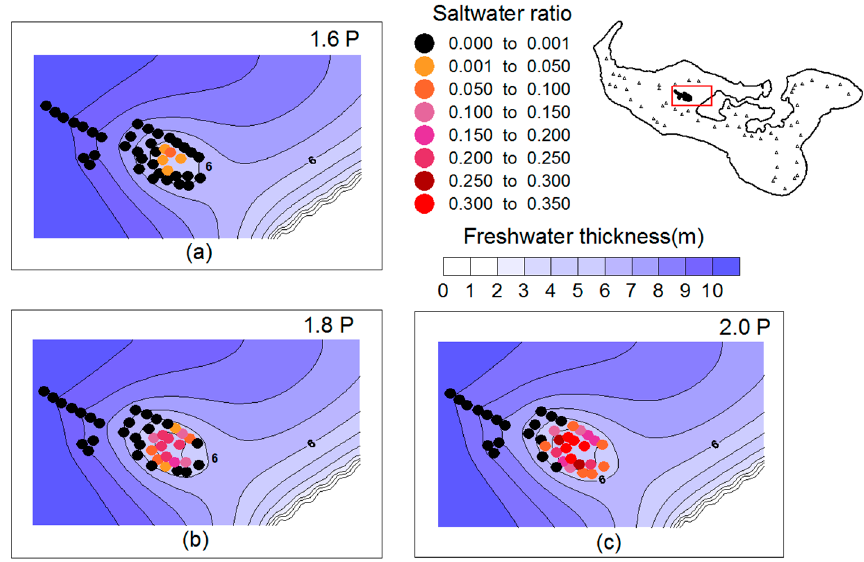
Figure 7. Saltwater intrusion into public wells under increase in current pumping (P = 16,710 m 3 /day) ( a ) 160% current pumping; ( b ) 180% current pumping; and ( c ) 200% current pumping.